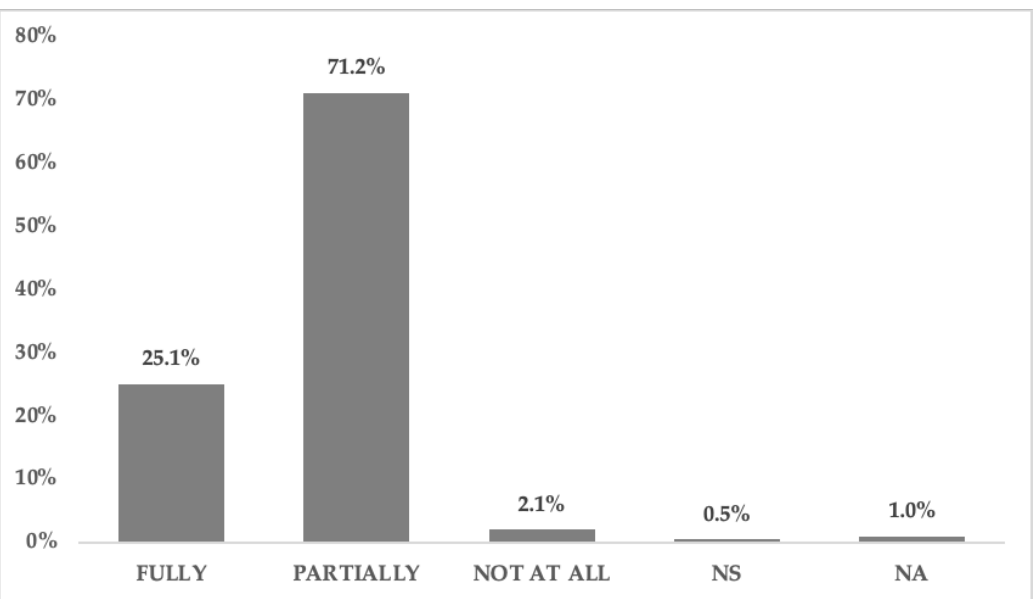
Figure 1. Understanding the information provided in advertising. A univariate descriptive analysis was conducted to observe the frequency distribution (NS = Not Sure/NA = No Answer). Table 2. Evaluation of the information presented in advertising. Complex, Medical Ambiguous and / or Scientific Jargon